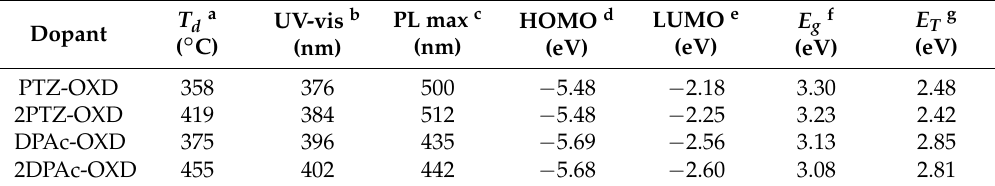
Table 1. Thermal and physical properties of fluorescent emitters.